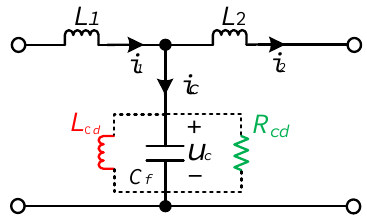
Figure 14. Generalized equivalent circuit for the bandwidth control method.